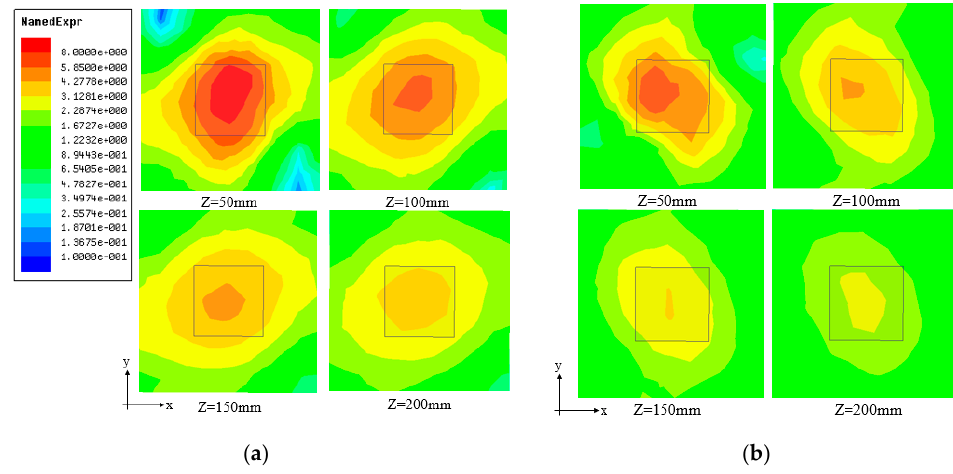
Figure 10. Distribution of simulated electric field components (Ex, Ey) at different heights with three spiral loops: ( a ) Ex distribution and ( b ) Ey distribution.